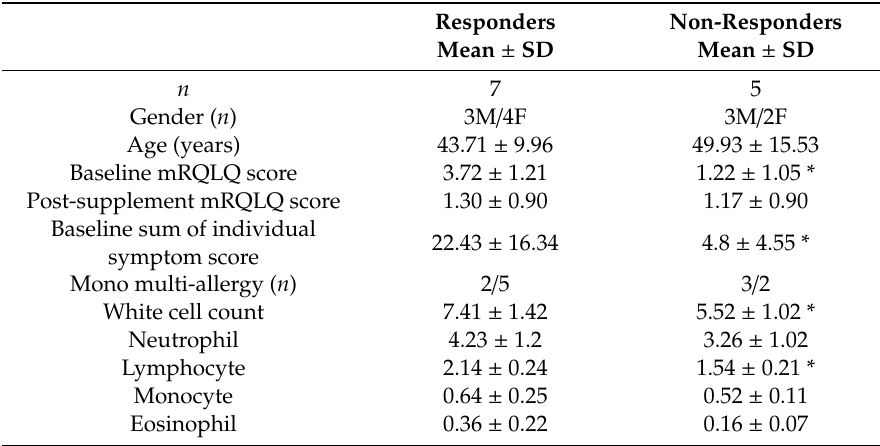
Table 1. Baseline characteristics of responders and non-responders included in the immune gene expression analysis. * p <